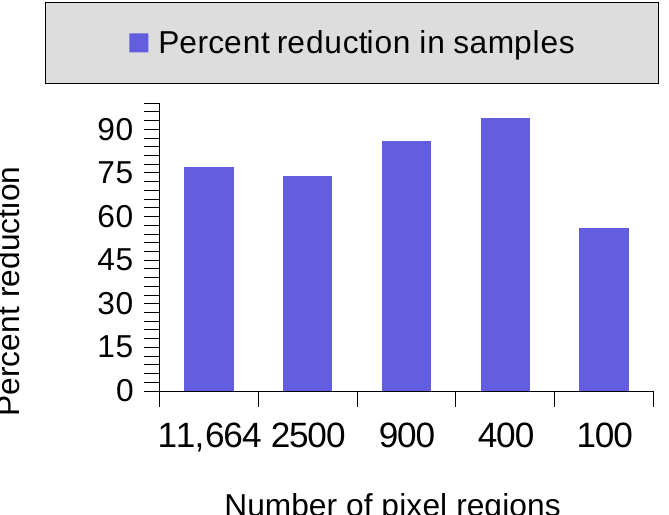
Figure 8. Percent decrease in samples needed to achieve full feature coverage by minimal set with respect to random